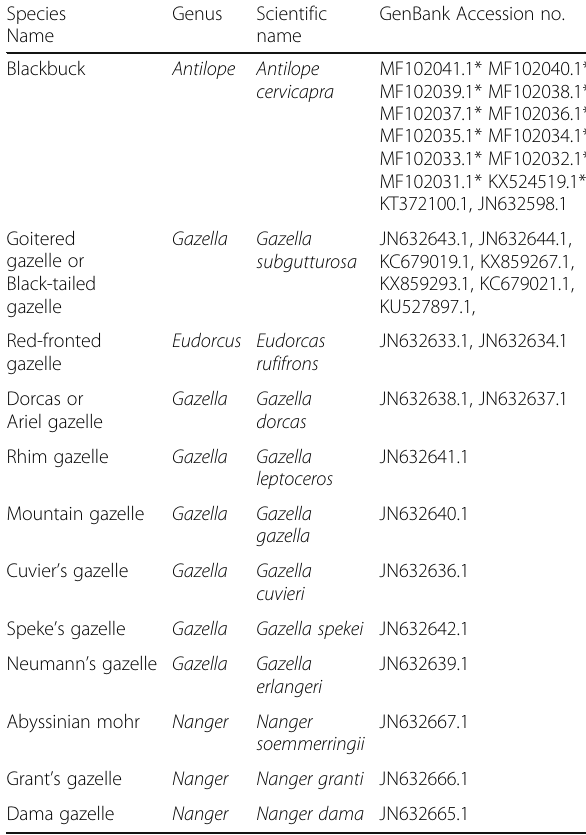
Table 1 Showing partial COI sequence of mtDNA used in this study from NCBI-GenBank